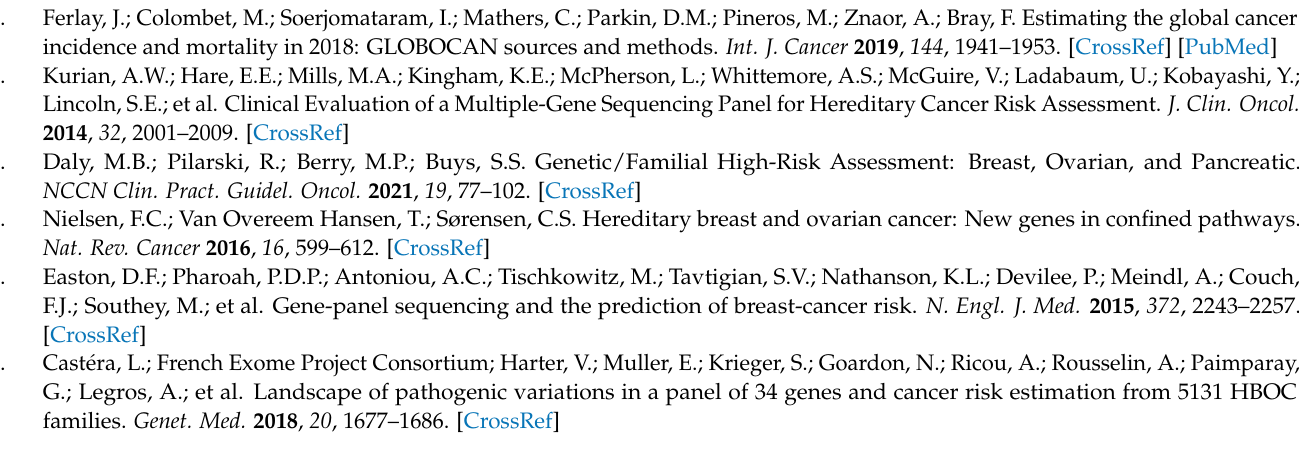
Figure S1: quality by base throughout the readings; Figure S2: quality values per